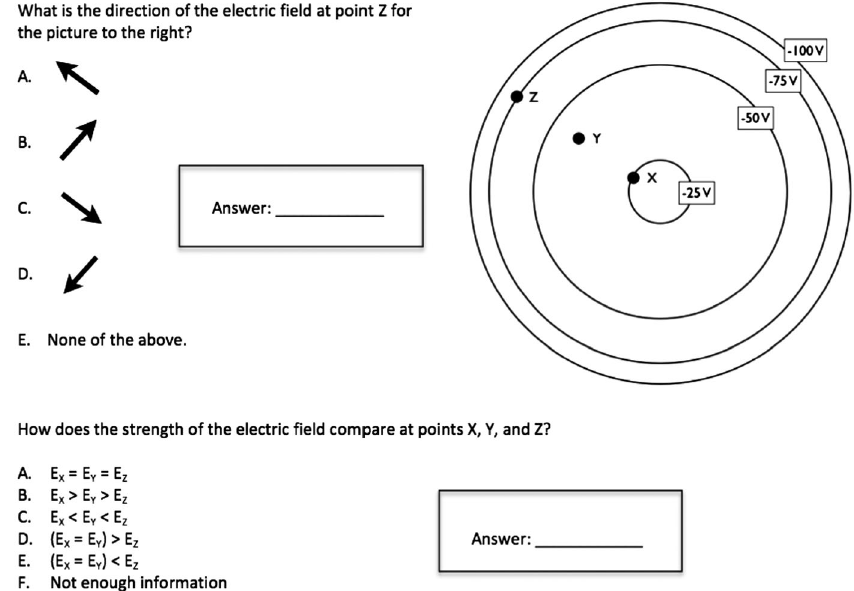
FIG. 4. Direction midtest question and magnitude midtest question asking students to use the equipotential lines to predict the electric field.